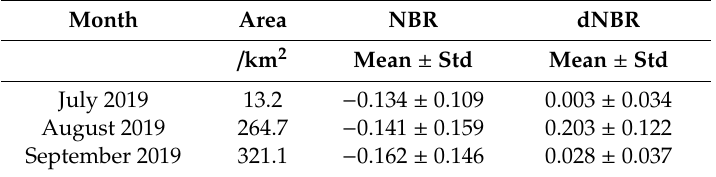
Table 3. The burned area and fire severity in the study area. NBR: Normalized Burn Ratio; dNBR: di ff erence of Normalized Burn